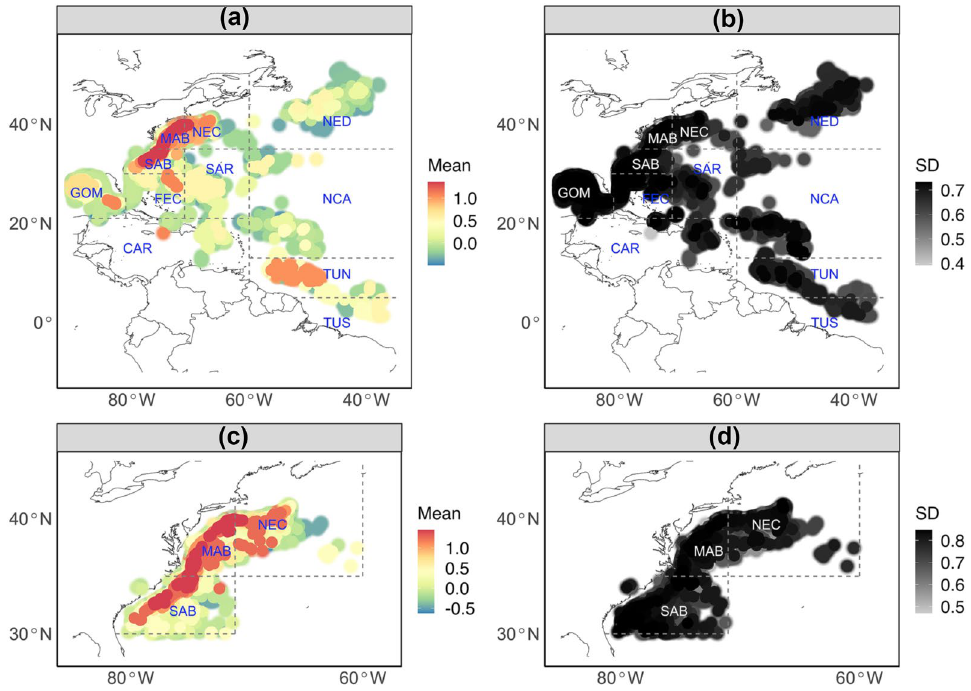
Figure 3. ( a,b ) Posterior mean and standard deviation of impacts of vessel ID on logit( p ) from model M7 fitted with data from 11 fishing zones. ( c,d ) Posterior mean and standard deviation of impacts of vessel ID on logit( p ) from model T7 fitted with data from the three high-bycatch zones. Vessel position is determined by longitude and latitude of start-setting location. Large and blurred points indicate approximate vessel positions because of the confidential concerns. Vessels with greater effects on logit( p ) are plotted on the top. Plot is made using R package ggplot2 (version 3.3.2, https:// ggplo t2. tidyv erse. org) in statistical program R (version 3.6.3, http:// www.R- proje ct. org/). Map data is from R package maps (version 3.3.0, https:// CRAN.R- proje ct. org/ packa ge= maps).